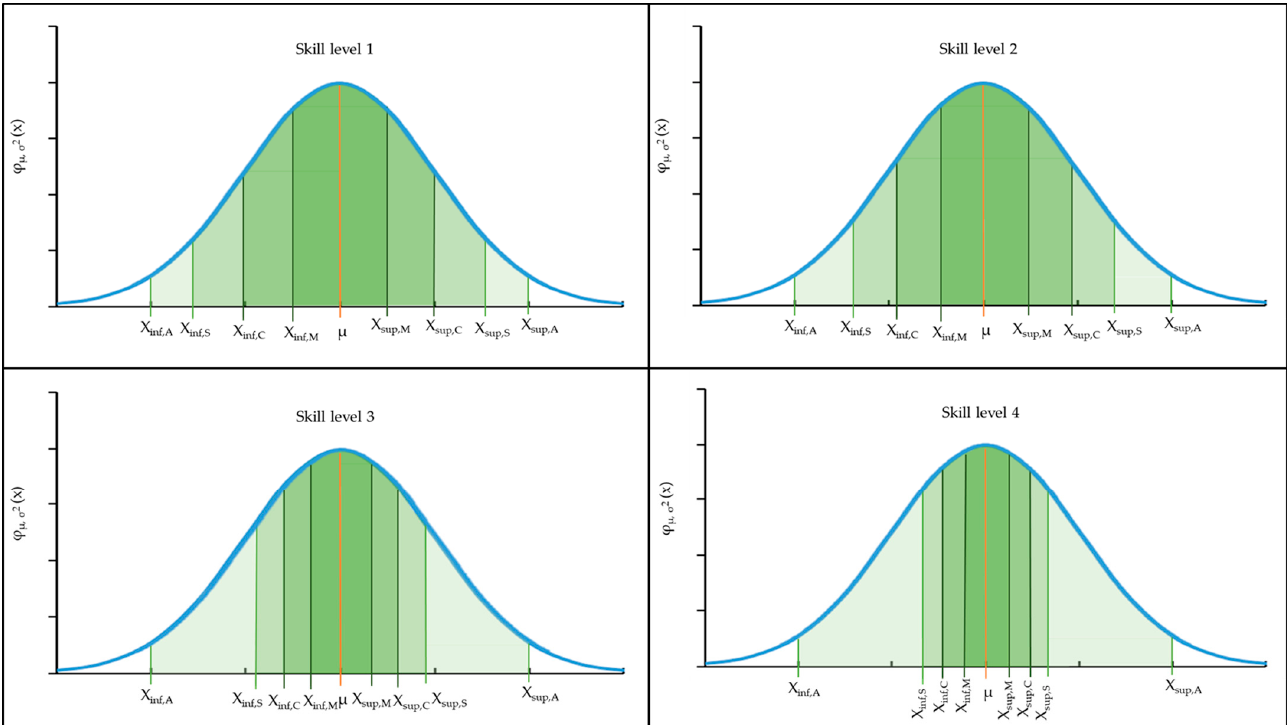
Figure 9. Gaussian distribution PDF with thresholds for different skill